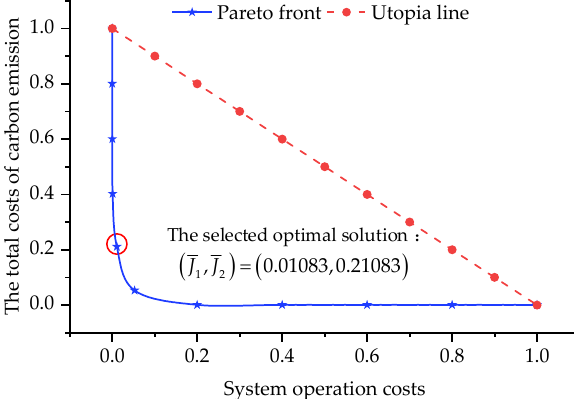
Figure 6. Pareto front and optimal compromise solution.